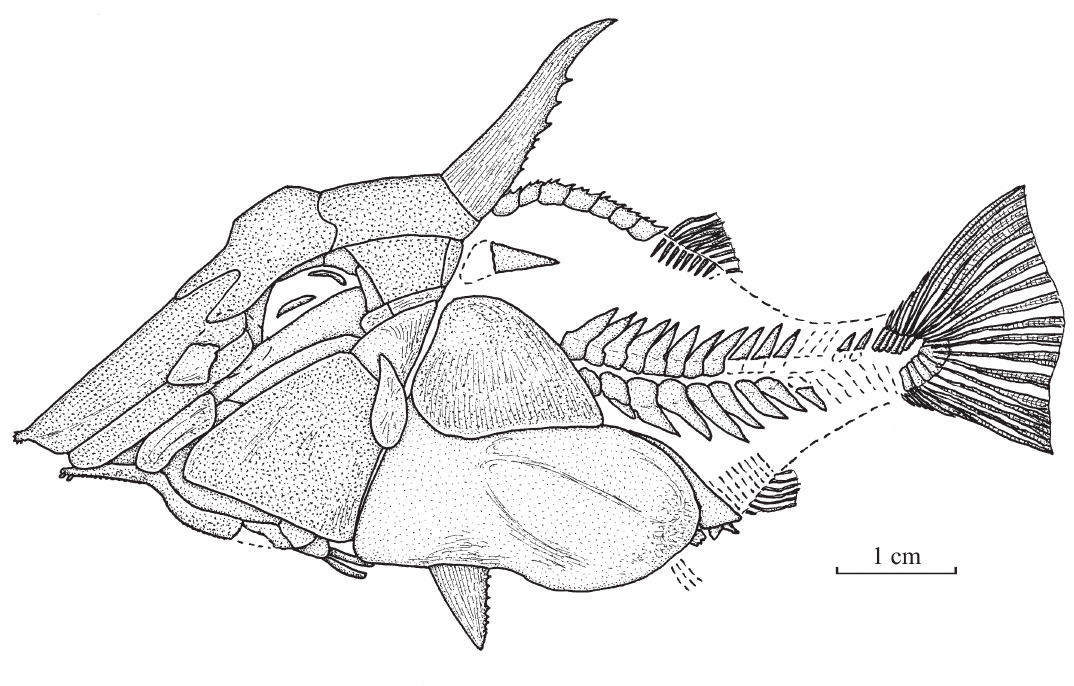
Fig. 13. Joinvillichthys kriweti gen. et sp. nov. General reconstruction based on holotype,